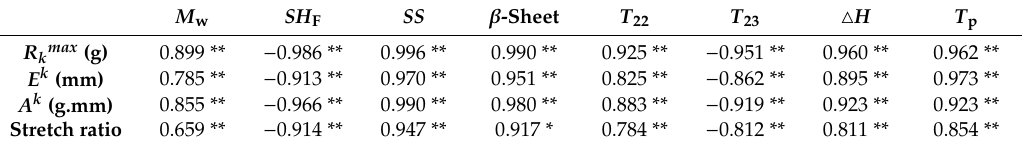
Figure 7. Tensile properties of frozen dough with different proportions of KGM added for 0 days frozen storage ( A ); 15 days frozen storage ( B ); 30 days frozen storage ( C ); 45 days frozen storage ( D ); and 60 days frozen storage ( E ). Table 3. The correlations between tensile characteristics and structure